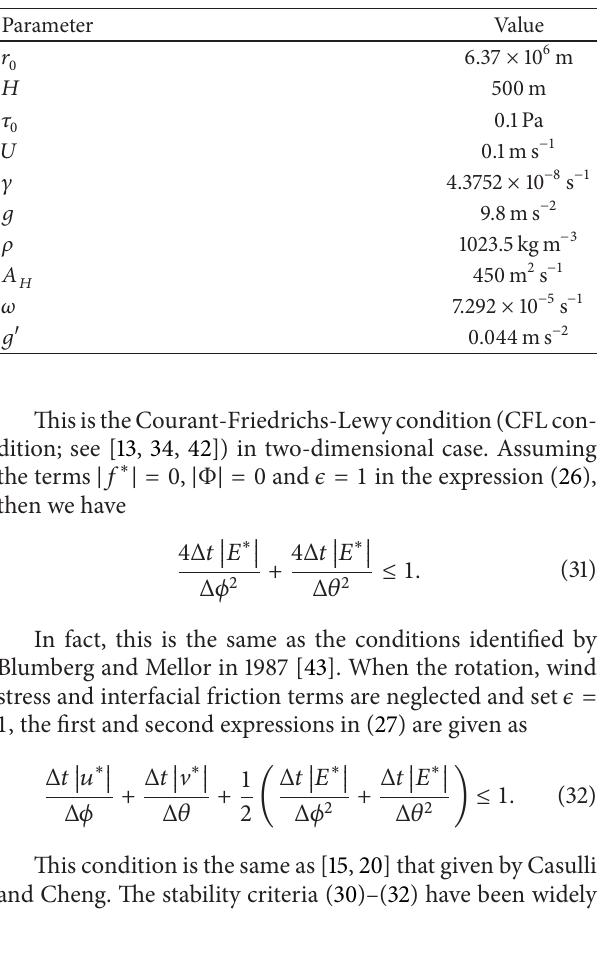
Table 1: The standard values of parameters in the